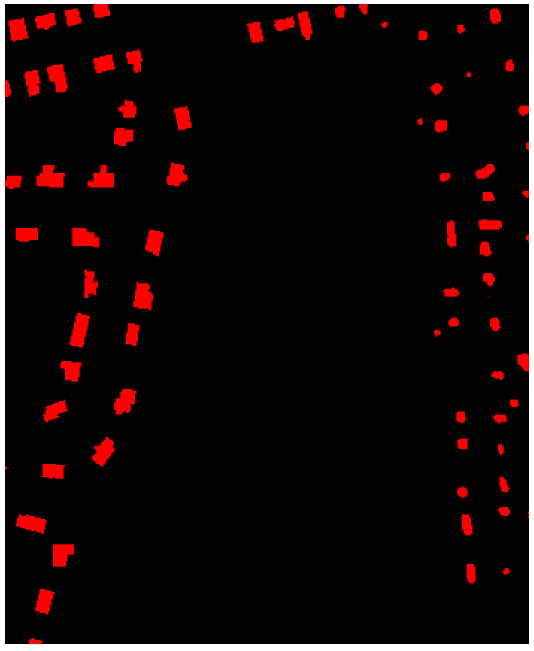
Figure 11. Automatic correction of the Massachusetts